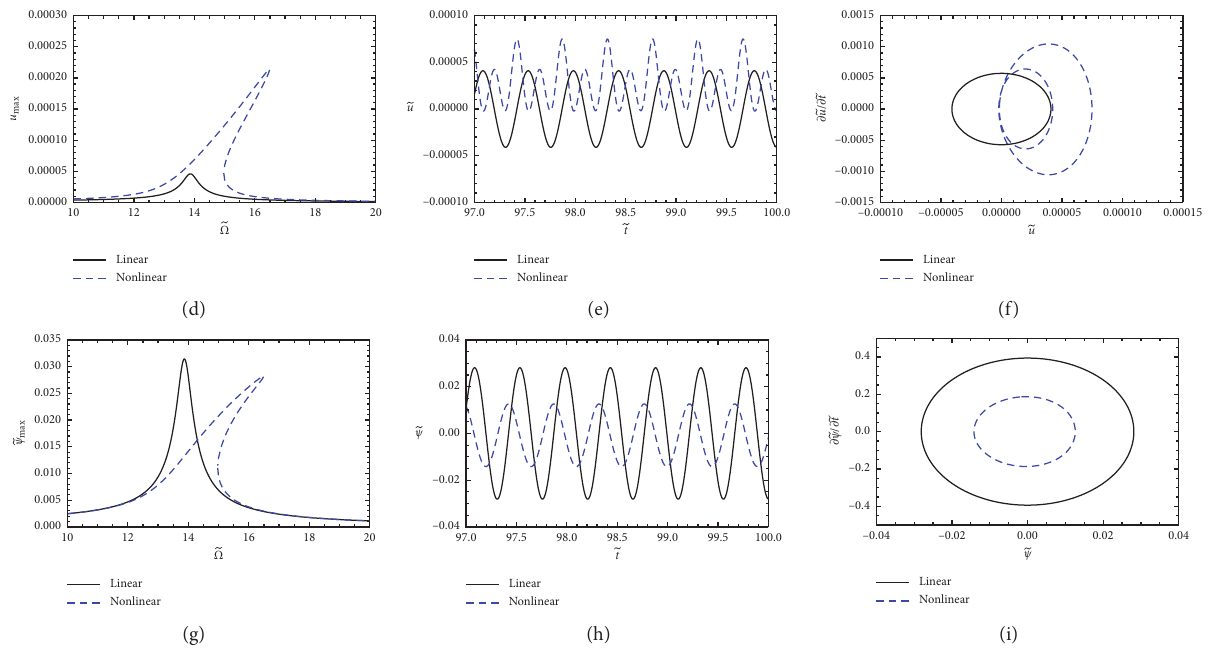
Figure 5: The comparison of linear and nonlinear dynamics response of SS BDFG porous beam when m 􏽥 c � 􏽥 c � 0 . 05, and 􏽥 f � 0 . 2. (a), (d), (g) Frequency-response curves; (b), (e), (h) time histories when 􏽥 Ω � 14; (c), (f), (i) phase diagrams. d r